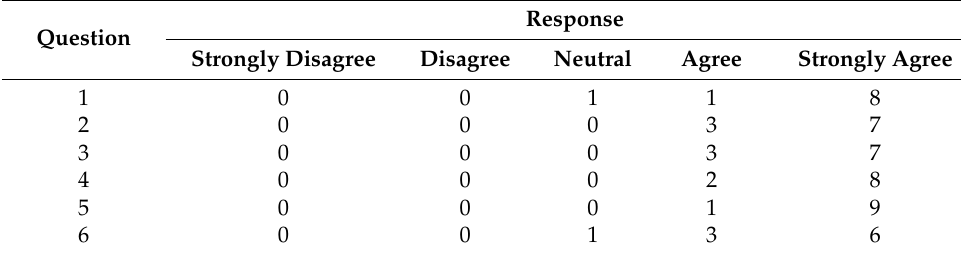
Table 4. Survey Responses to MR2CS’s